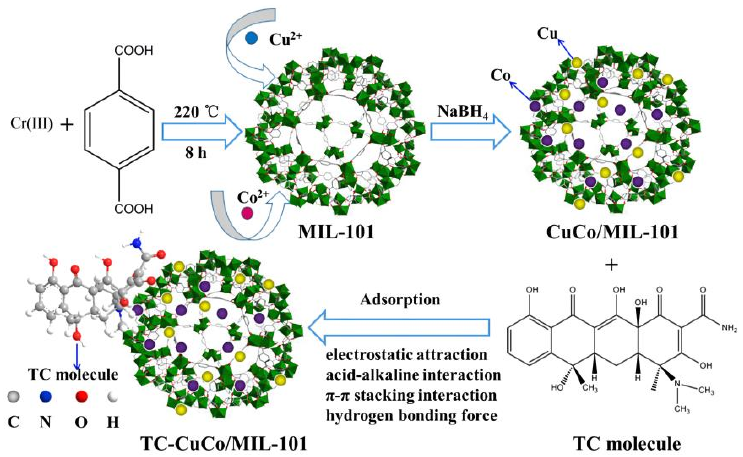
Figure 13. Schematic diagrams of the synthesis of Cu@Co/MIL-101 and the adsorption progress of tetracycline [128] . Reprinted from ref. [128]. Copyright © 2022, with permission from